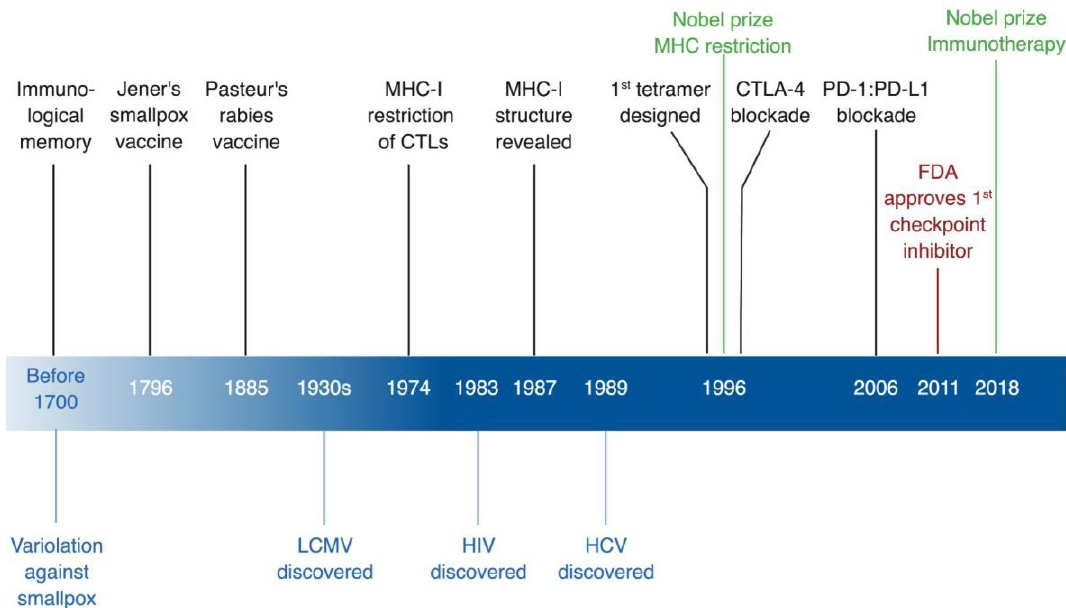
Figure 1. Timeline of immunological discoveries guided by viruses. In black, immunological discoveries, in green, related Nobel Prizes, in red, FDA approvals, and in blue virological discoveries. CTLs, cytotoxic T lymphocytes; CTLA-4, cytotoxic T lymphocyte antigen 4; FDA, US Food and Drug Administration; HCV, hepatitis C virus; HIV, human immunodeficiency virus; LCMV, lymphocytic choriomeningitis virus; MHC-I, MHC class I; PD-1, programmed cell death-1; PD-L1, programmed cell death ligand-1. * Created with BioRender.